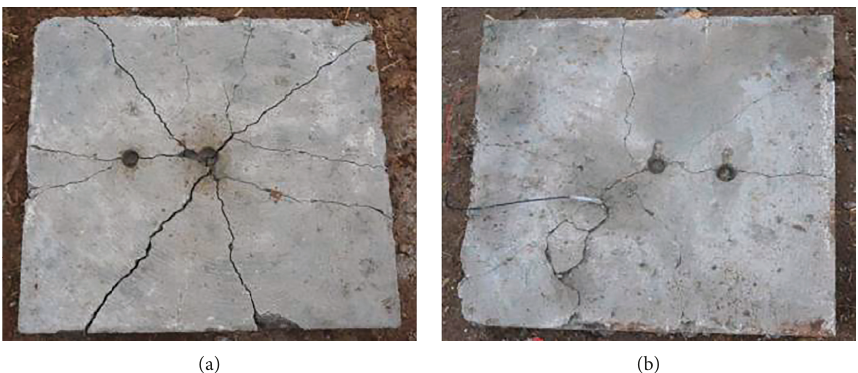
Figure 15: Damage to the bottom of the concrete in Tests 2 (a) and 3 (b).